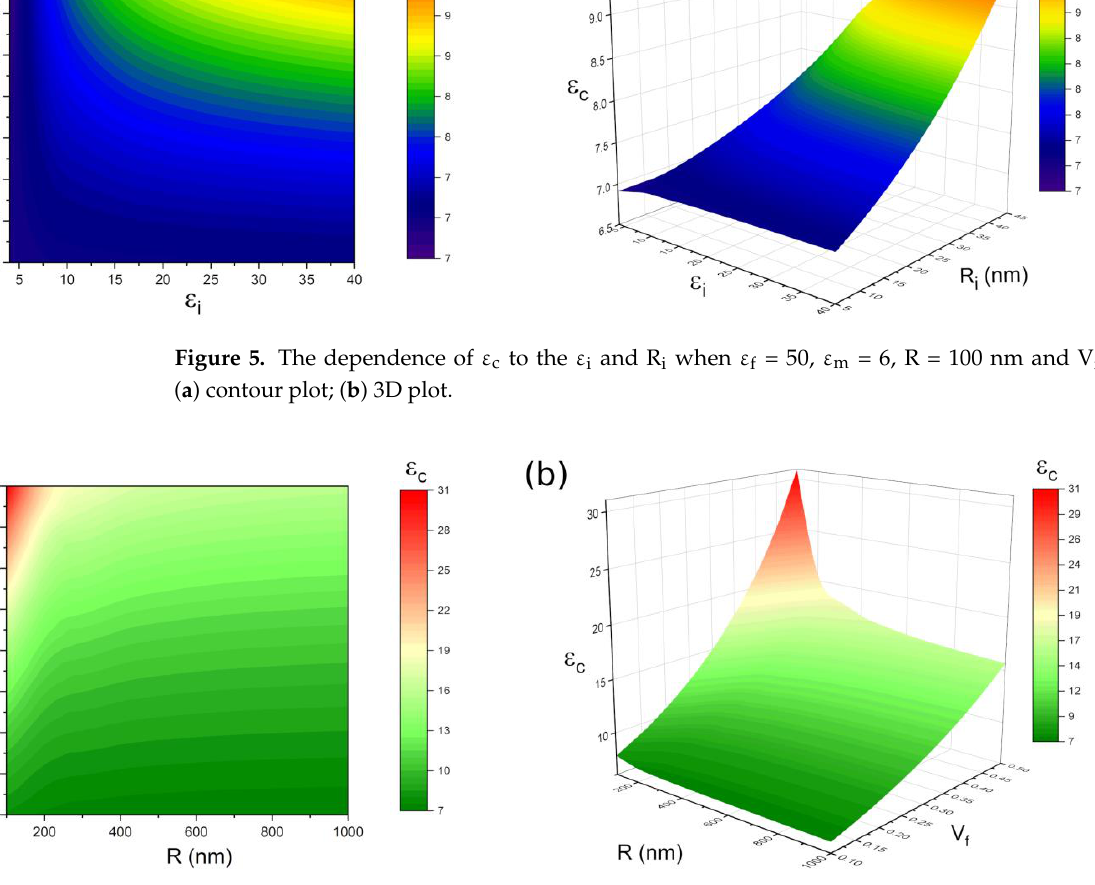
Figure 6. The dependence of ε c to the R and V f when ε f = 50, ε m = 6, ε i = 20, R i = 25 nm ( a ) contour plot; ( b ) 3D plot.